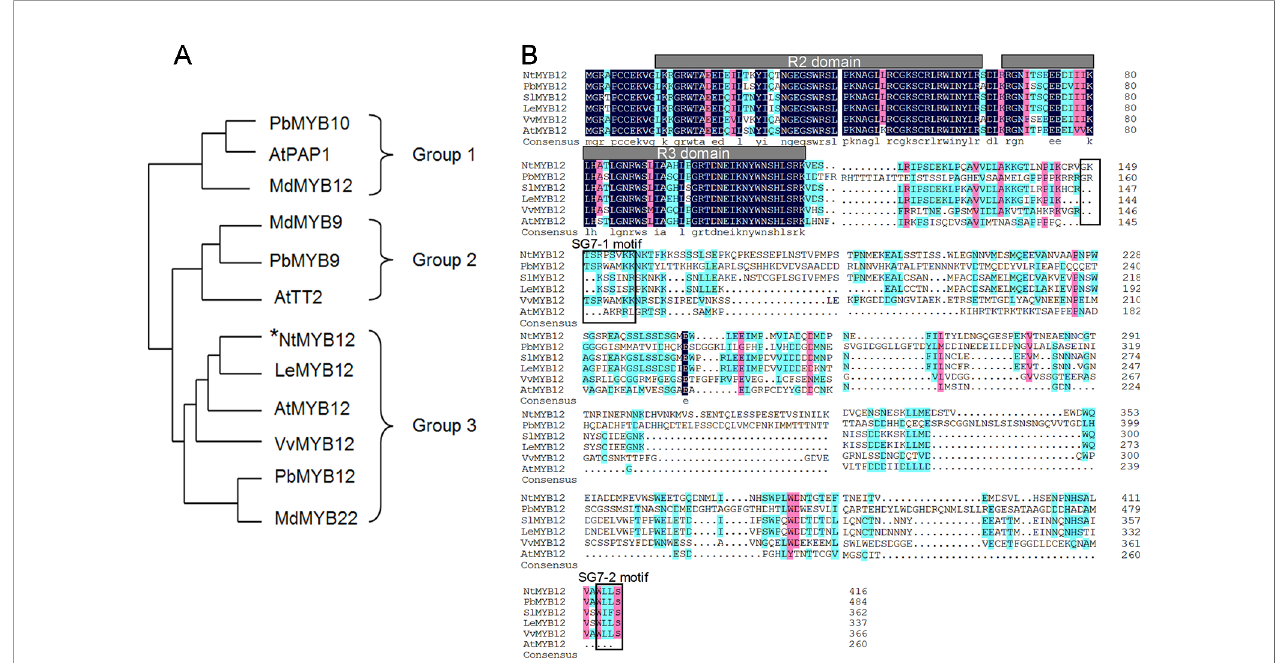
FIGURE1 | Sequence alignment and phylogenetic analysis of NtMYB12 . (A) Phylogenetic analysis of typical fl avonoid-regulating MYBs from different species. These MYBs were classi fi ed into three major groups. The MYB protein sequences in other species were obtained from the NCBI database. Their protein accessions in the NCBI database are as follows: pear PbMYB10 (ALU57825.1), Arabidopsis PAP1 (AEE33419.1), apple MdMYB12 (ADL36755.1), apple MdMYB9 (ABB84757.1), pear PbMYB9 (ALU57827.1), Arabidopsis TT2 (OAO91653.1), Arabidopsis MYB12 (ABB03913), grapevine VvMYB12 (XP_002269995), PbMYB12 (ALF95174.1), and apple MdMYB22 (AAZ20438.1). The phylogenetic tree was constructed by MEGA7.0 using a bootstrap test of phylogeny with the Neighbor-Joining test and default parameters. (B) Protein sequence alignments of PFG-type MYBs from different species. The conserved R2 and R3 domains are underlined. Previously described SG7 – 1 and SG7 – 2 motifs are boxed. The multiple alignments were performed using DNAMAN